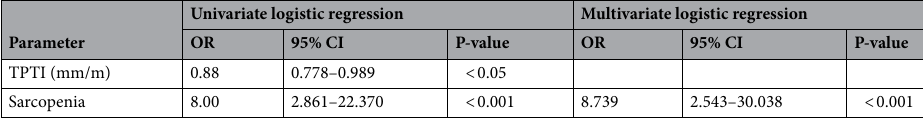
Table 6. Univariate and multivariate logistic regression analyses for malnutrition. TPTI transversal psoas thickness